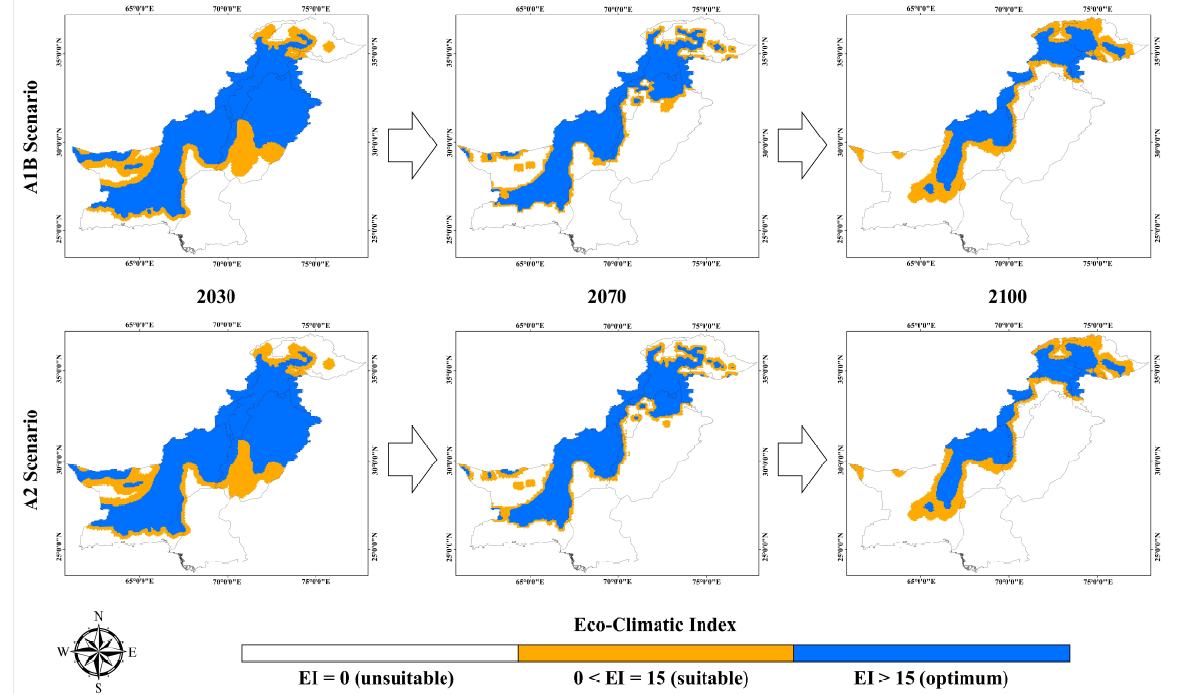
Figure 4. Forecast potential distribution of Aelosthes sarta in Pakistan under future climatic conditions for time periods of 2030, 2070, and 2100 under A1B and A2 climate change scenarios. The projected global distributions (three colors) narrate the ecoclimatic index (EI) from the CLIMEX model: blue → optimum (EI > 15); orange → suitable (0 < EI = 15), and white → unsuitable (EI = 0).